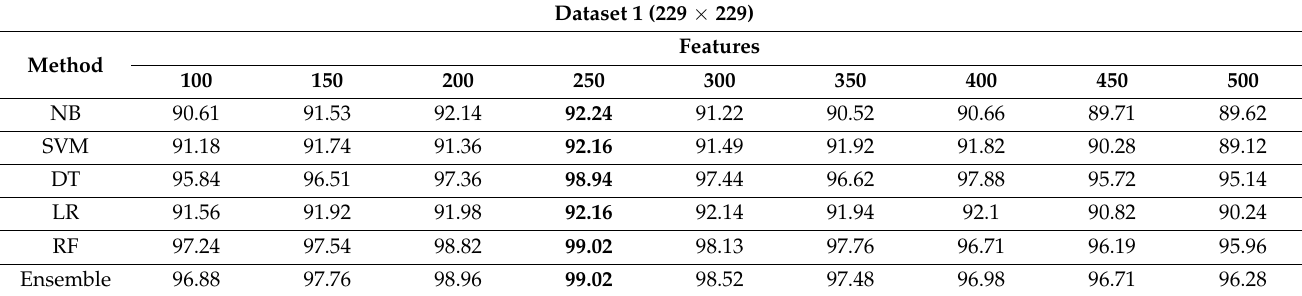
Table 8. Optimum feature analysis.